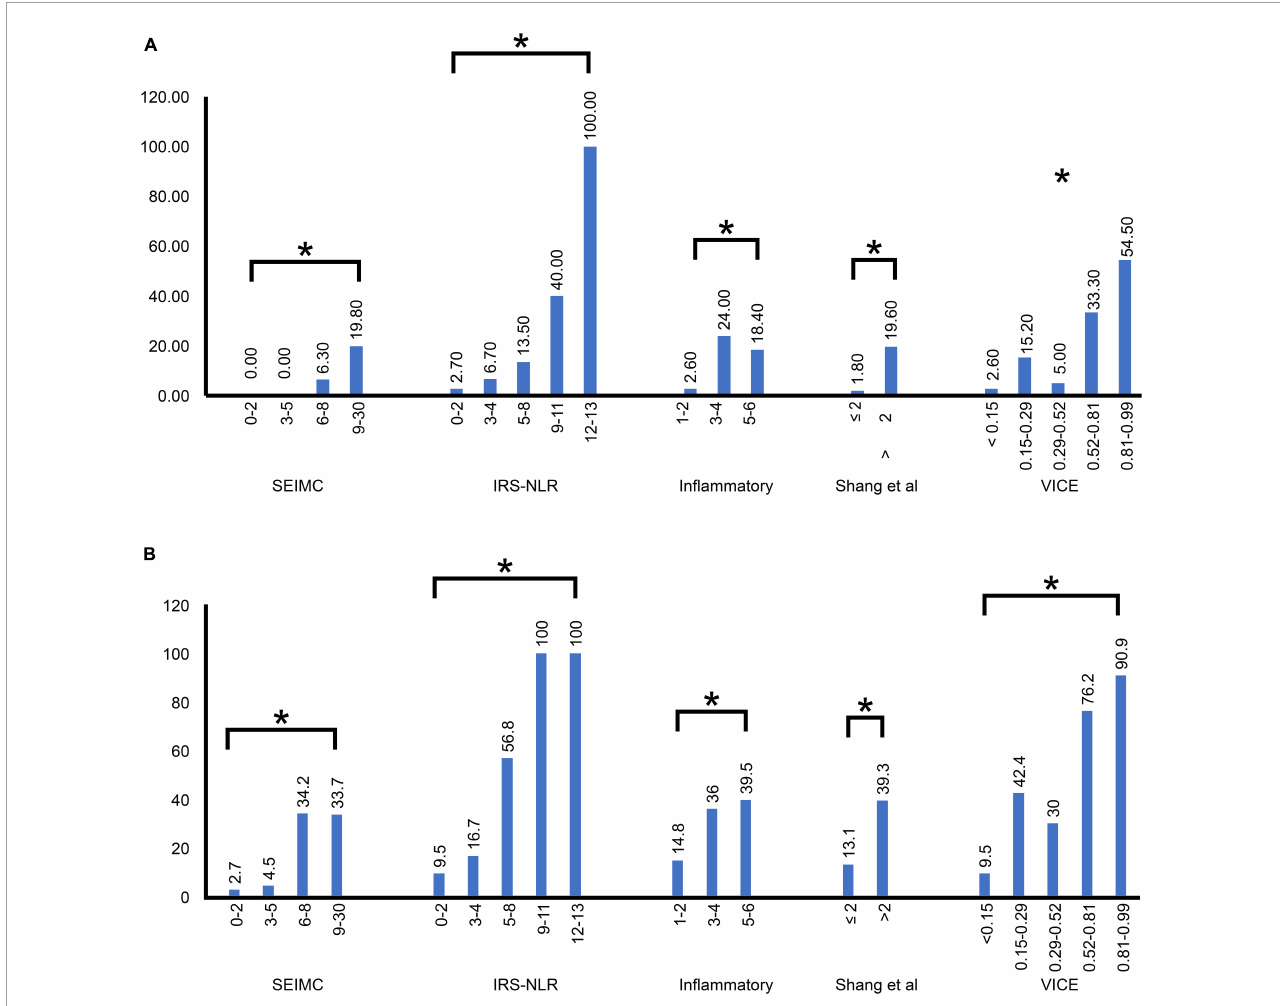
FIGURE1 Distribution of the SEIMC, IRS-NLR, inflammatory, Shang et al., and VICE scores by risk class in our patients. (A) The mortality rate was plotted against five score stratifications. (B) The intubation rate was plotted against five score stratifications. The correlation between each of the five scoring systems and the increase in severity. * p < 0.001; SEIMC, Spanish Society of Infectious Diseases and Clinical Microbiology; IRS-NLR, intubation risk score-neutrophil/lymphocyte ratio; VICE, ventilation in COVID